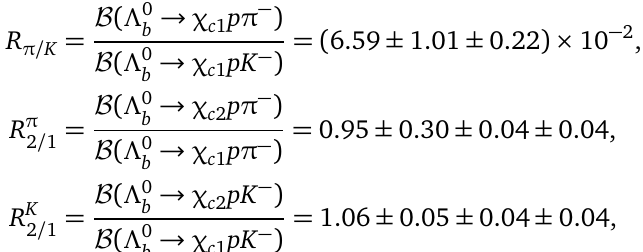
→ χ p π − (left) and Λ 0 c 1 b